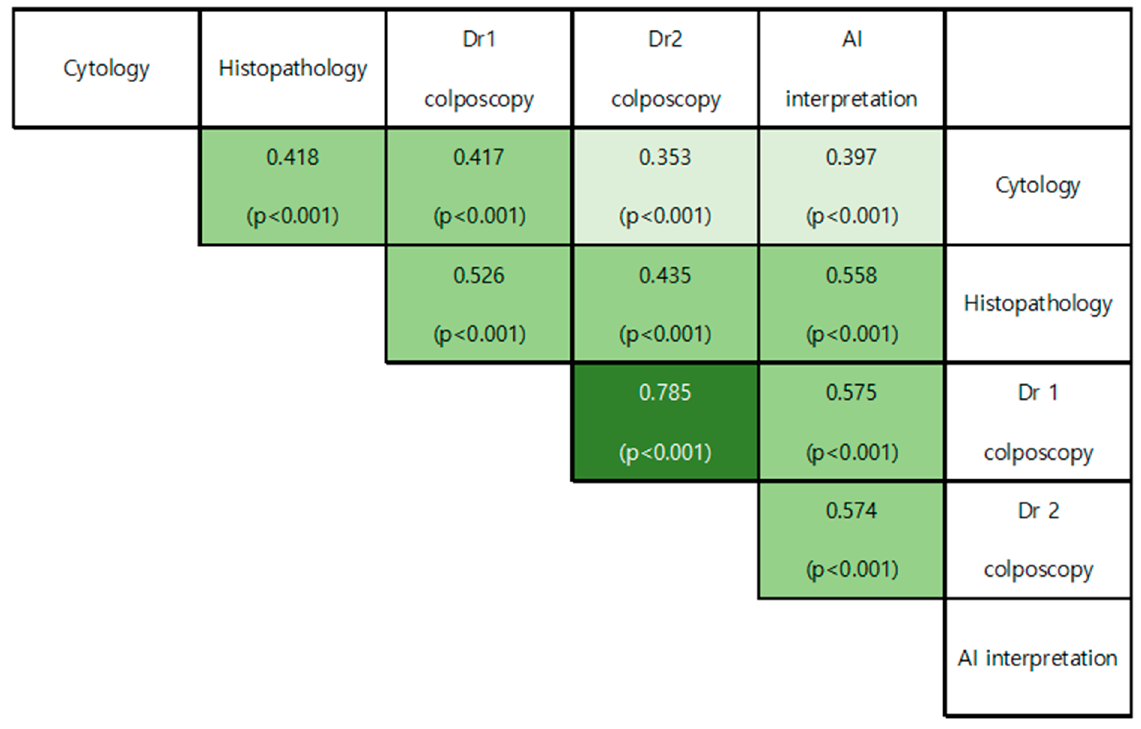
Figure 3. Correlations between each diagnostic tool. Values are expressed as Pearson’s R ( p